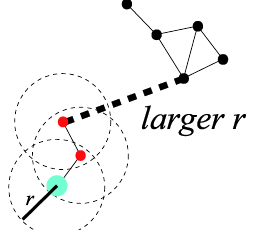
Figure 5. Graphical description of decomposition by Euclidean distance